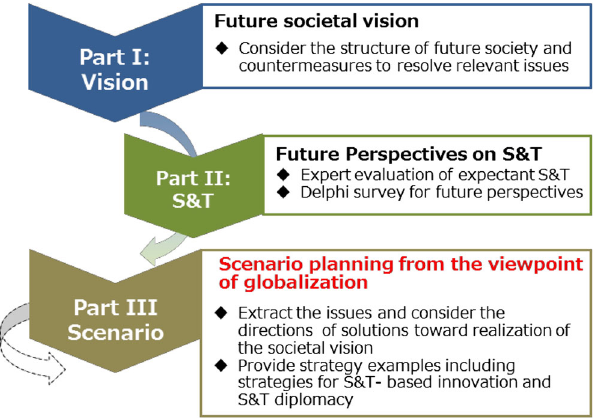
Fig. 1 Outline of the 10th S&T foresight (Source: NISTEP